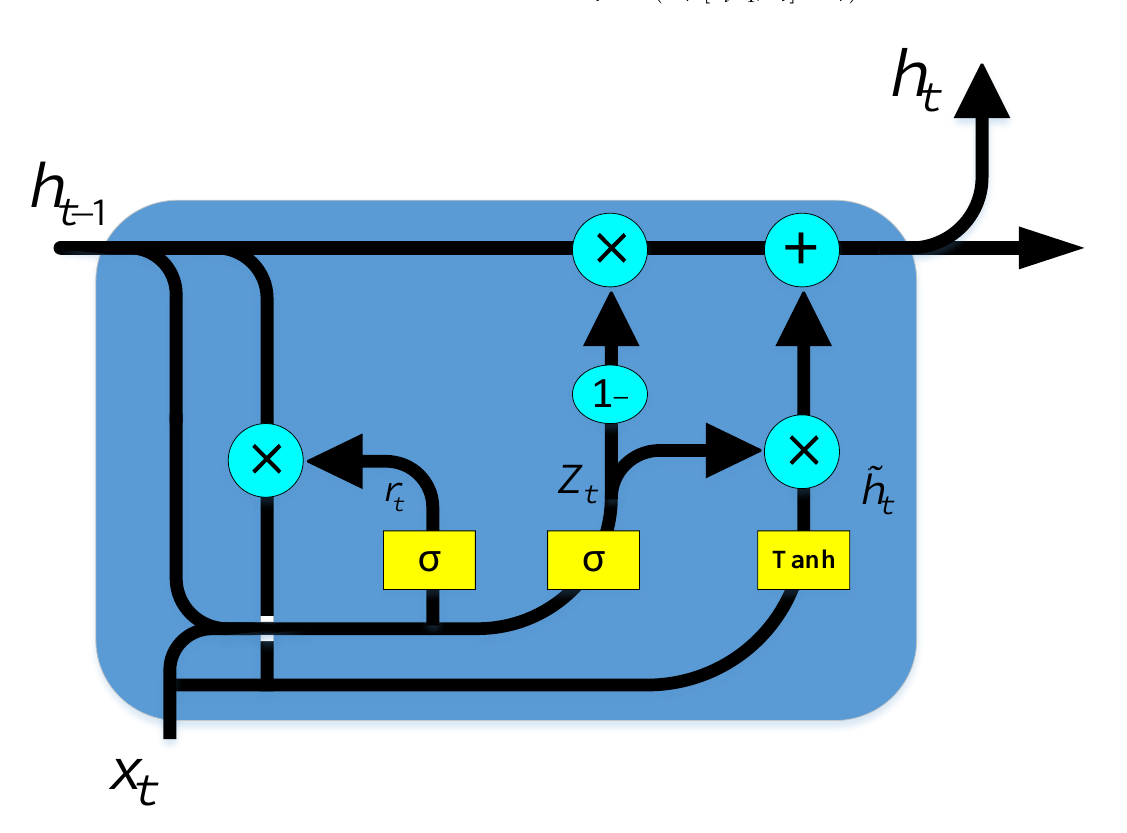
Figure 5. GRU algorithm block diagram.